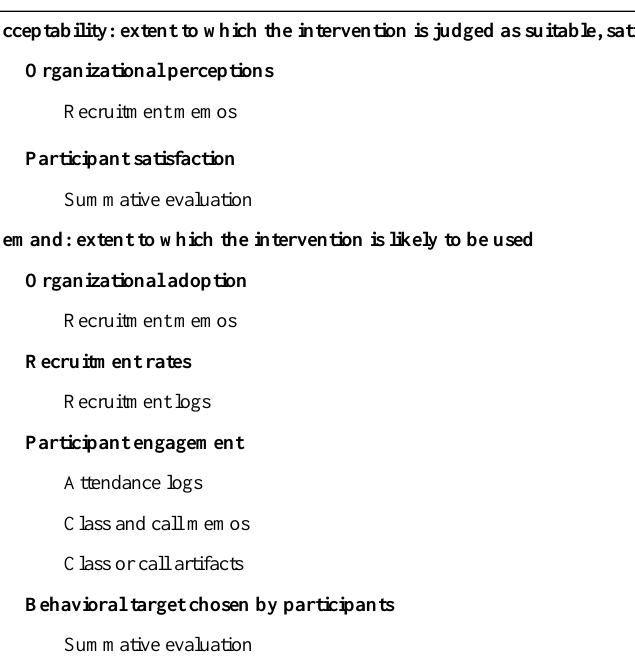
Process evaluationPostassessmentBaselineFeasibility domain, definition, indicator, and measure